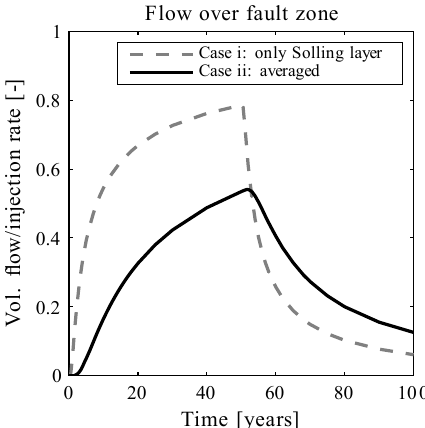
Figure 15. Focused leakage scenario. Results of the Analytical Model for the two cases: (i) the injection horizon comprises only the Solling sandstone layer and (ii) the injection horizon comprises all layers in the Middle and Lower Buntsandstein with an averaged injection horizon permeability and